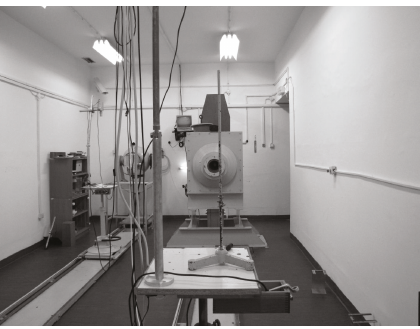
Figure 2: Standard Co-60 radiation field used in the Laboratory for Radiation Protection at the Institute of Nuclear Sciences “Vinˇca.”